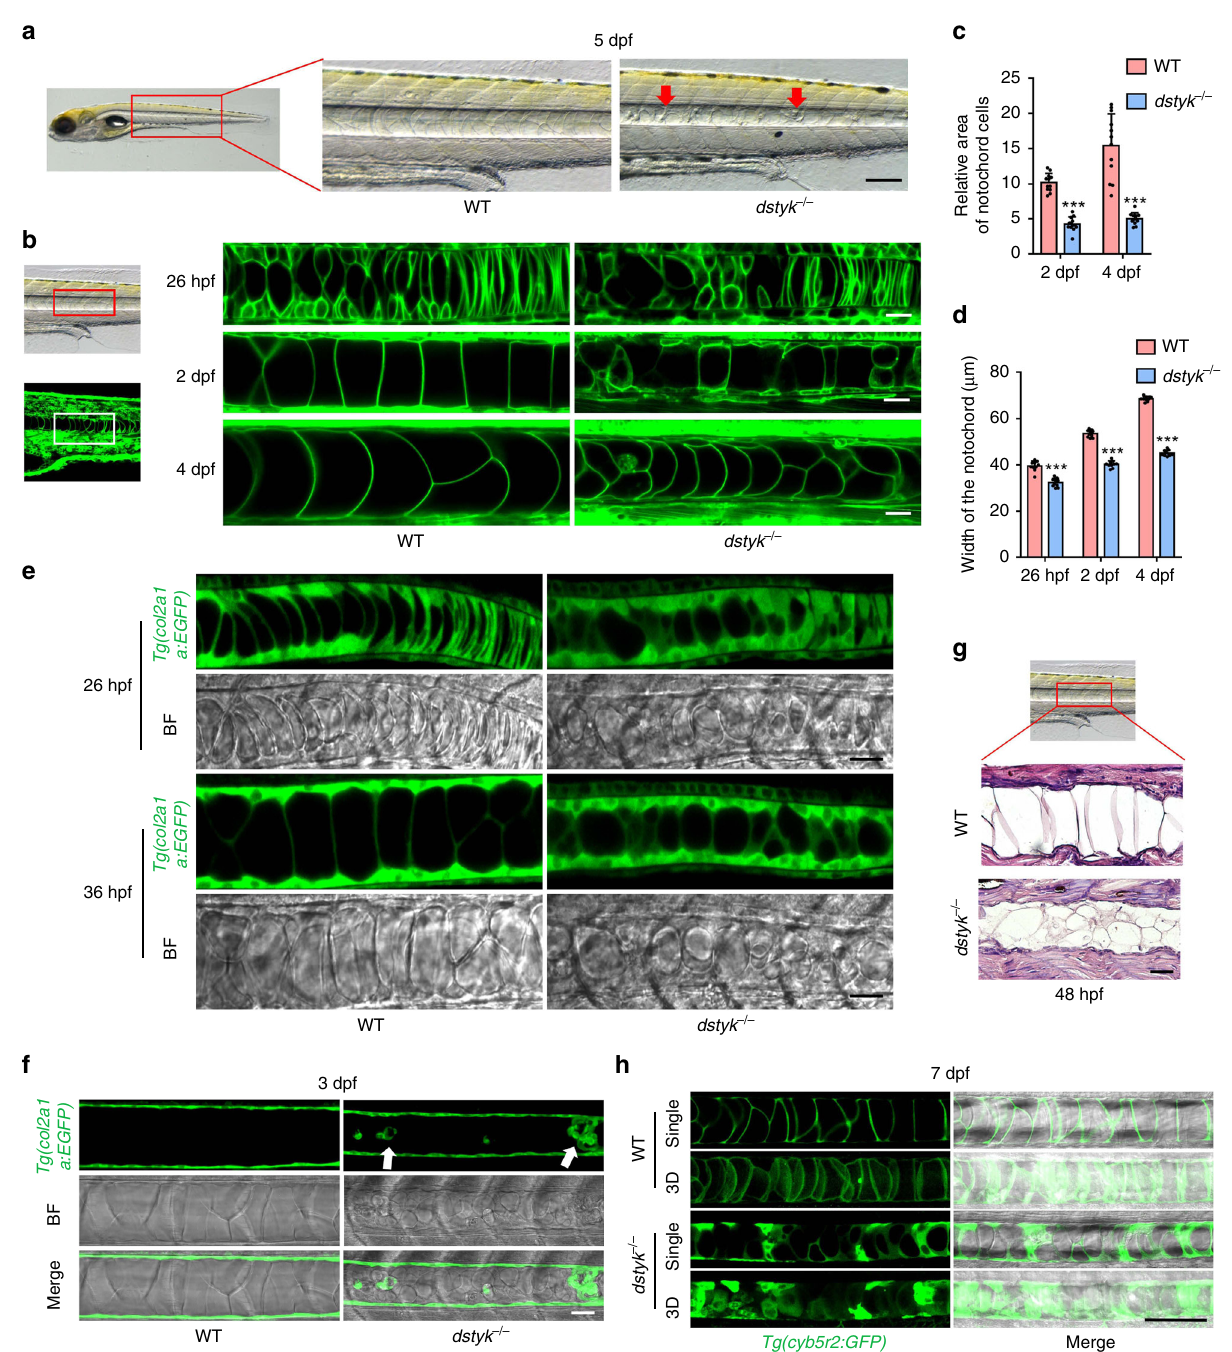
Fig. 4 The phenotype of dstyk mutants in the notochord. a Bright- fi eld images showing the WT and dstyk mutant at 5 dpf. Red arrow indicates the small granular structure accumulated in the notochord. b Live confocal images showing the notochord development of WT and dstyk mutant in Tg( β -actin:ras- GFP) transgenic background from 26 hpf to 4 dpf. All cell membranes were labeled by EGFP. c Quanti fi cation of relative area of single notochord cell for WT and dstyk mutant at 2 dpf and 4 dpf. n = 10 independent embryos for WT and dstyk mutant, 10 notochord cells were counted for each embryo. d Quanti fi cation of width of the notochord for WT and dstyk mutant from 26 hpf to 4 dpf. n = 12 independent embryos for WT and dstyk mutant. *** p < 0.001. p values were determined by unpaired two-tailed Student ’ s t -test. e Live confocal time-lapse images showing notochord development of WT and dstyk mutant in Tg(col2a1a:EGFP) transgenic background (left) and bright- fi eld (right) at 26 hpf and 36 hpf. f Live confocal images of WT and dstyk mutant in Tg(col2a1a:EGFP) transgenic background at 3 dpf. White arrow indicates ectopic Col2a1a positive cells in the notochord in the mutants. g Hematoxylin and eosin staining of longitudinal sections of the notochord in WT and dstyk mutant at 48 hpf. h Confocal images showing the notochord of WT and dstyk mutants in Tg(cyb5r2:GFP) transgenic background at 7 dpf. All notochord cells were labeled by EGFP. Data are presented as mean ± SD. Scale bar represent 20 μ m in ( b , e , f and g ), 100 μ m in ( a and h ). Source data are provided as a Source Data fi